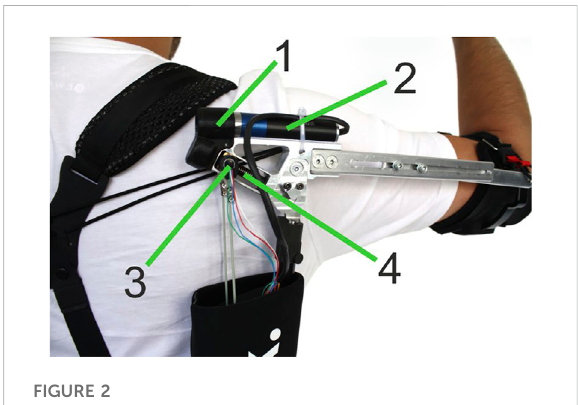
FIGURE 2 Actuated joint of the adaptive Paexo Shoulder: 1)